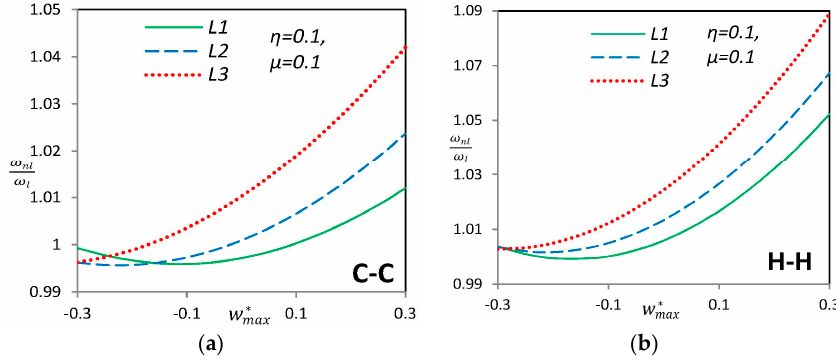
Figure 5. Variation of nonlinear vibration frequency ratio for ( a ) clamped-clamped and ( b ) hinged-hinged endpoint conditions of a nonlocal nano-beam for various “L” types imperfection. Figure 6 focuses on the effect of nonlocal parameter on the nonlinear frequency ratio of SWCNTs.